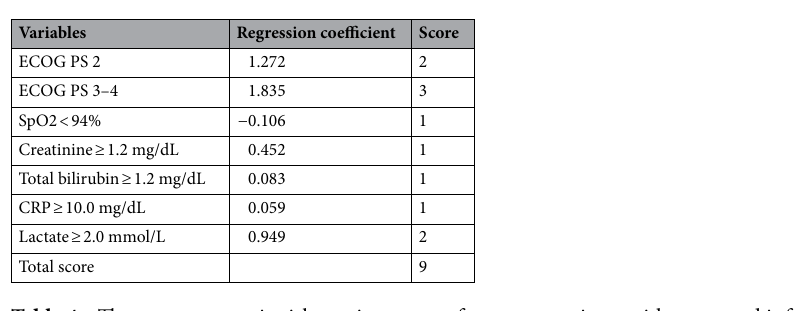
Table 4. The new prognostic risk scoring system for cancer patients with suspected infection. CRP C-reactive protein, ECOG Eastern Cooperative Oncology Group, PS performance status, SpO 2 peripheral oxygen